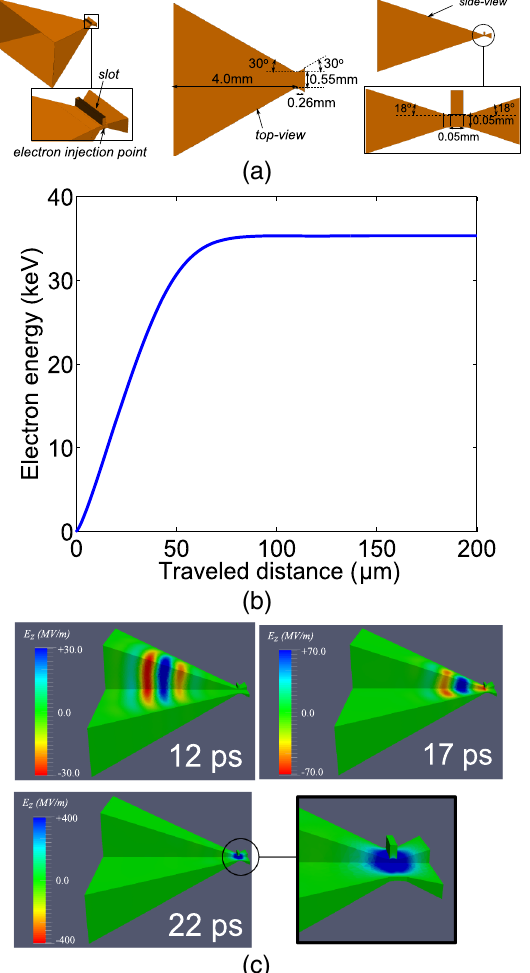
FIG. 3. (a) Schematic illustration of the low energy ultrafast electron gun, (b) Energy of the accelerated electron versus the z ¼ traveled distance, and (c) Snapshots of ( E space cuts of the gun. Note the change in the color map scaling for different